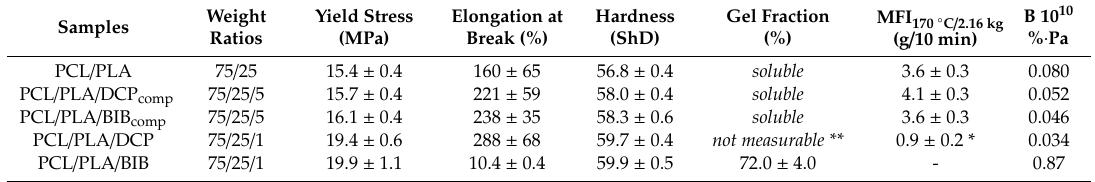
Table 4. Physico-mechanical and rheological properties of PCL / PLA